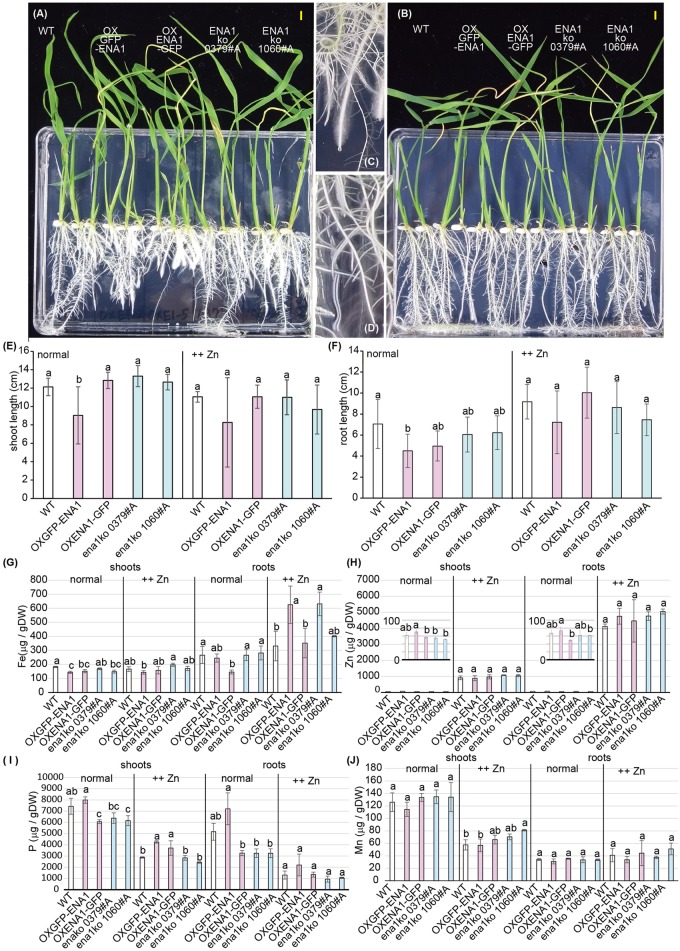
Plant phenotype of ena1 knockout mutants (0379#A and 1060#A), GFP-ENA1- or ENA1-GFP-overexpressing rice plants, and WT. Rice plants grown on MS medium (normal) or MS medium with high zinc (Zn) concentrations (++Zn). (A–D) Plant appearance at 12 days after germination under normal (A,C,D) or high (Zn (B) conditions. Scale bars represent 0.5 cm. Roots pictures of ENA1-GFP overexpressing (C) or wild-type (WT) plants (D) under normal conditions are enlarged. (E,F) Shoot length (E) and root length (F) were measured 12 days after germination. Error bars represent the standard error (n = 9). (G–J) Fe, Zn, manganese (Mn), and phosphorus (P) concentrations in the shoots and roots of ena1 knockout mutants, GFP-ENA1- or ENA1-GFP-overexpressed rice plants, and WT. Values represent means of three replicates. Error bars represent standard deviations. DW, dry weight. Different letters indicate significant differences according to the Tukey–Kramer HSD test (n = 9, P < 0.05).)